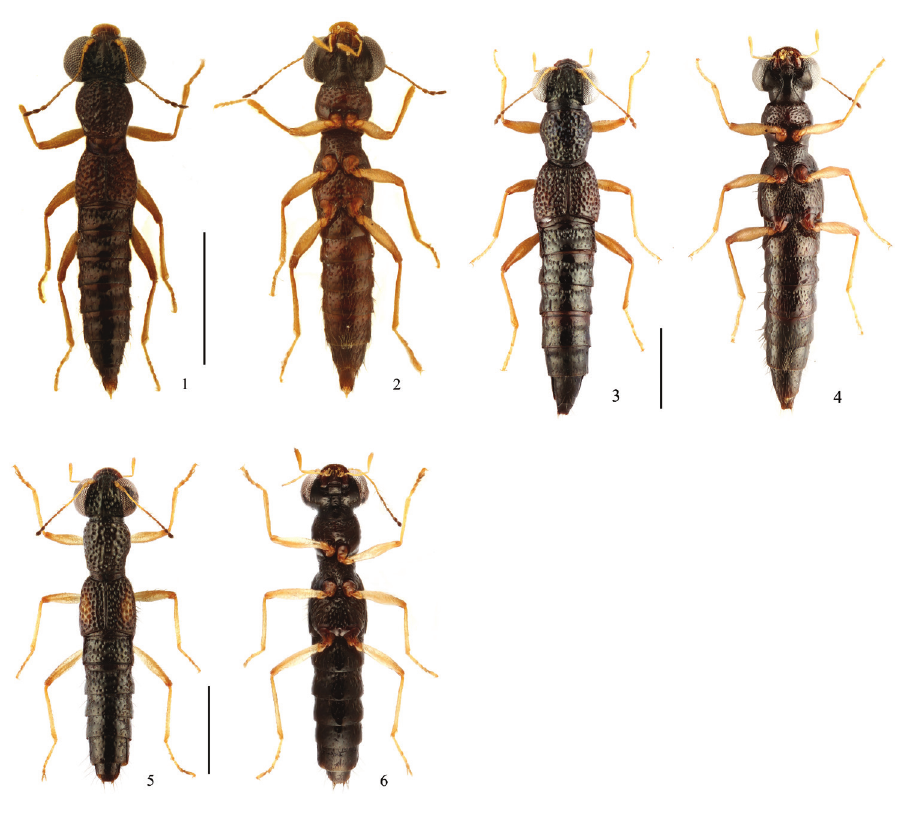
Figures 1–6. Habitus. 1, 2 Stenus wuyanlingus sp. n. 3, 4 Stenus yuyimingi sp. n. 5, 6 Stenus ovalis . Scale bars: 1 mm. 1550 m. 6.V.2012, ZHU Jian-Qing leg”. “Holotype / Stenus wuyanlingus / Liu